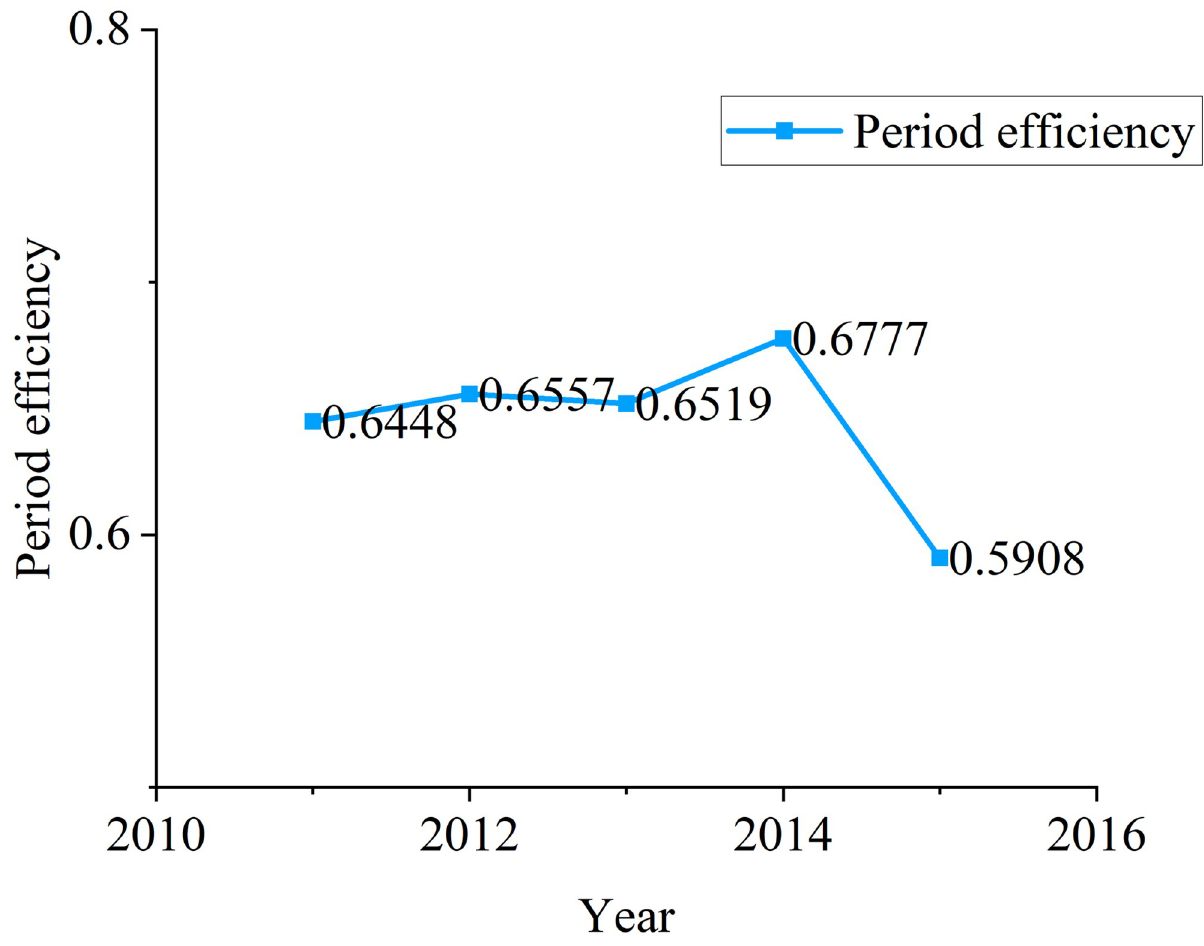
Fig 4. Change trend of period